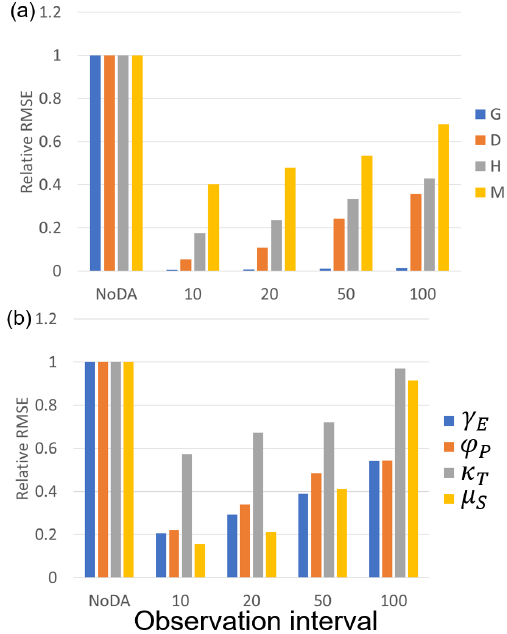
Figure 9. The ratio of the RMSEs of the no data assimilation (NoDA) experiment to those of the data assimilation (DA) exper- iments in which all of observations ( F , G , D , H , and M ) are as- similated every 10, 20, 50, and 100 years in experiment 2 (see Sect. 3.1.2). (a) Blue, orange, gray, and yellow bars are RMSEs of the size of the human settlement G(t) , the center of the mass of the human settlement from the river D(t) , the flood protection level (or levee height) H(t) , and the social awareness of the flood risk M(t) . (b) Blue, orange, gray, and yellow bars are RMSEs of the cost of levee raising γ E , the rate at which new properties can be built ϕ P , the rate of decay of levees κ T , and the memory loss rate µ S